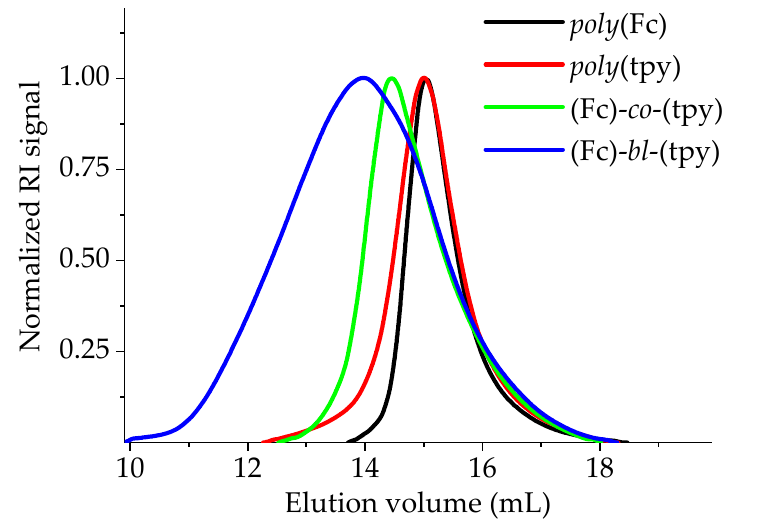
Figure 2. Normalized SEC curves of the four polymers (eluent: CHCl 3 /isopropanol/NEt 3 in a 94:2:4 volume